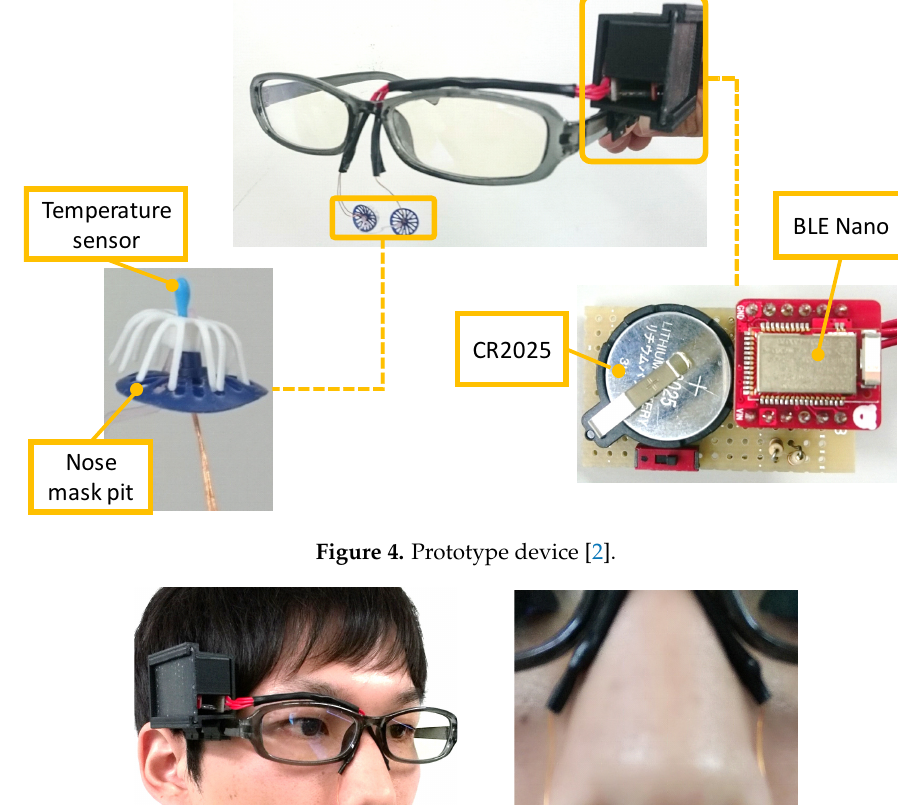
Figure 5. A user wearing the prototype